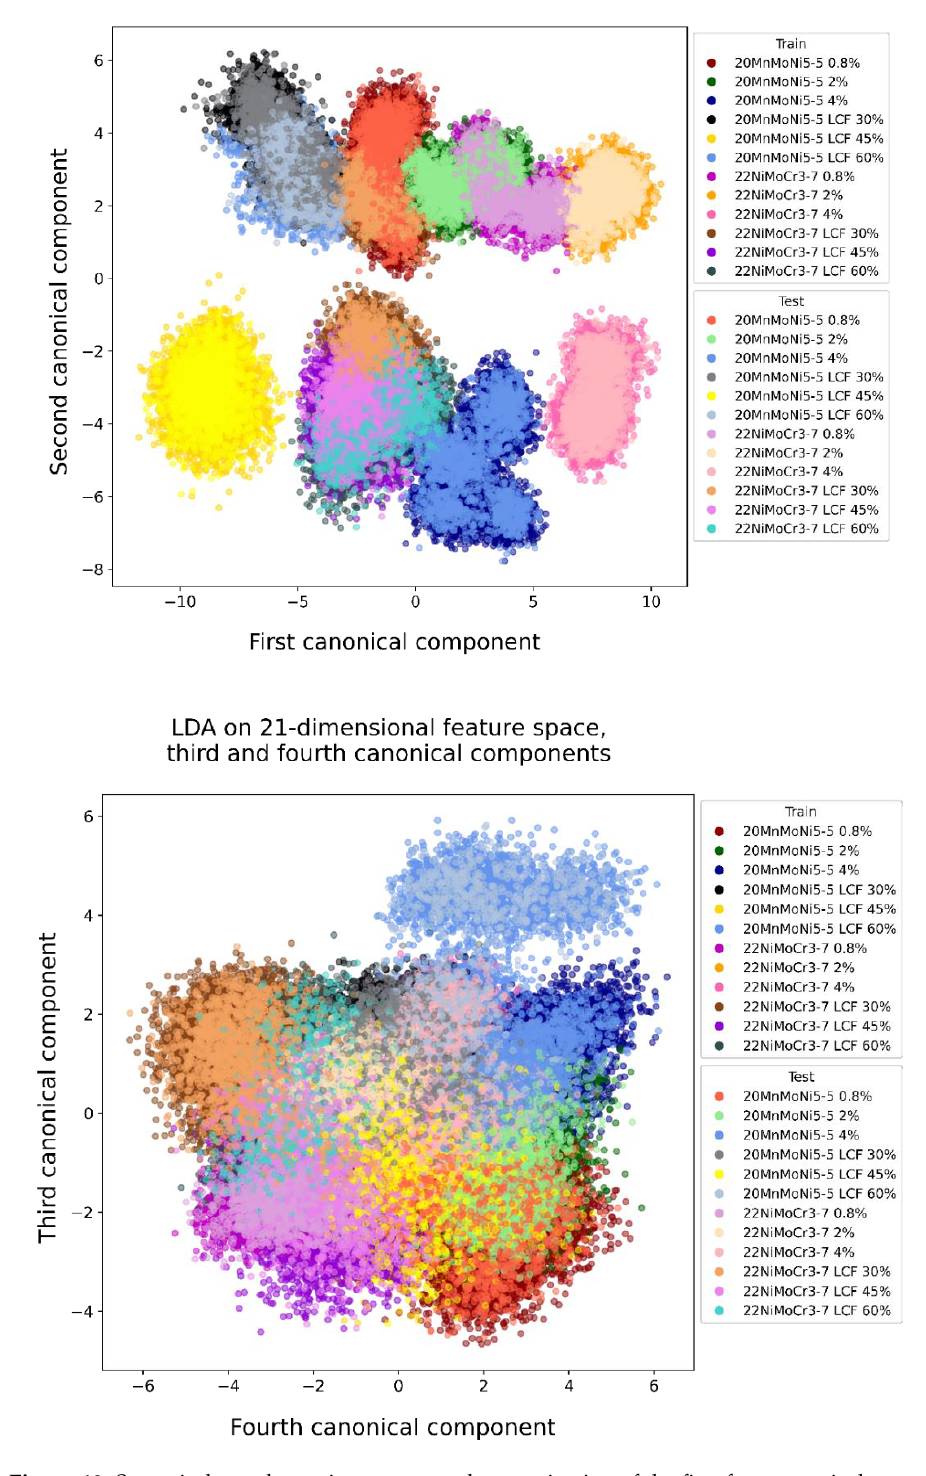
Figure 10. Stress-independent microstructure characterization of the first four canonical components transformed by LDA, 21-dimensional feature space.